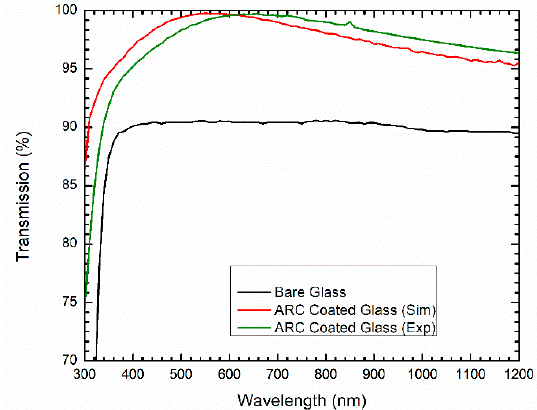
Figure 3. Transmission spectra of Coating.